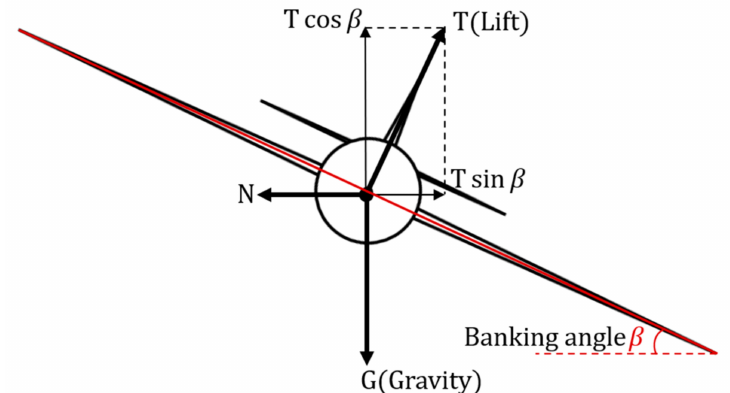
Figure 2. The force diagram of a turning plane with a banking angle of β .